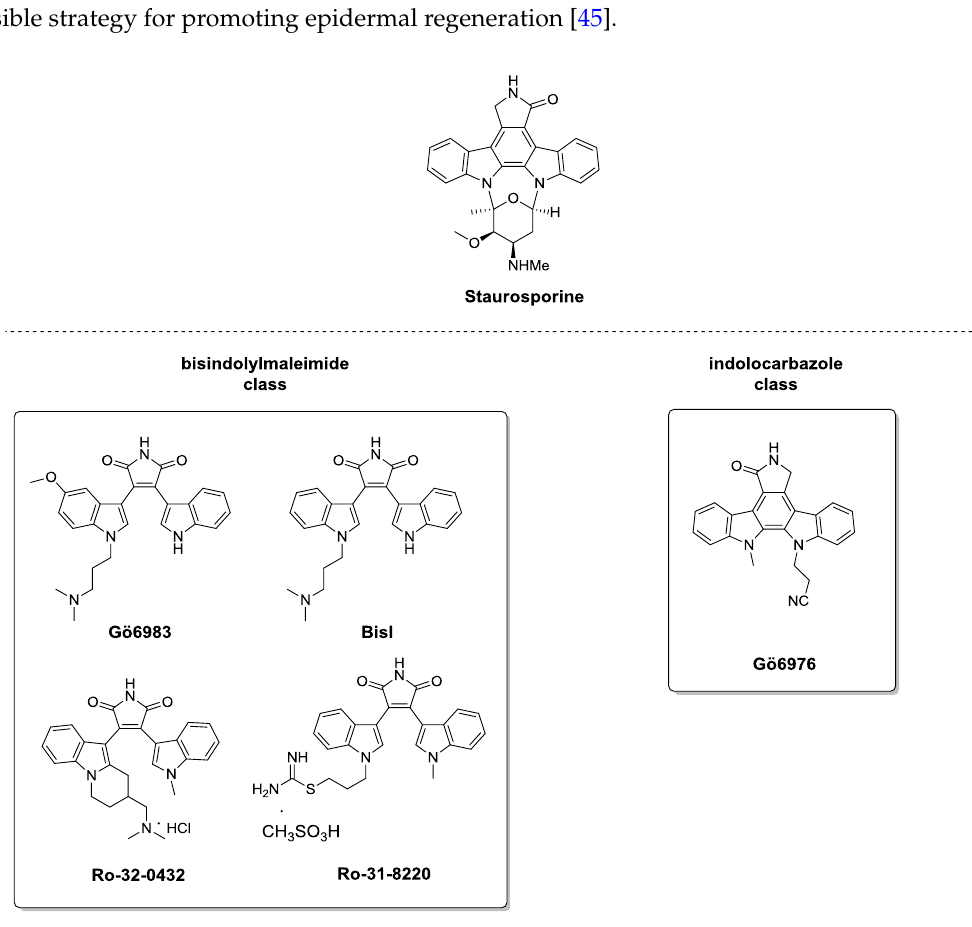
Figure 4. Staurosporine derivatives.